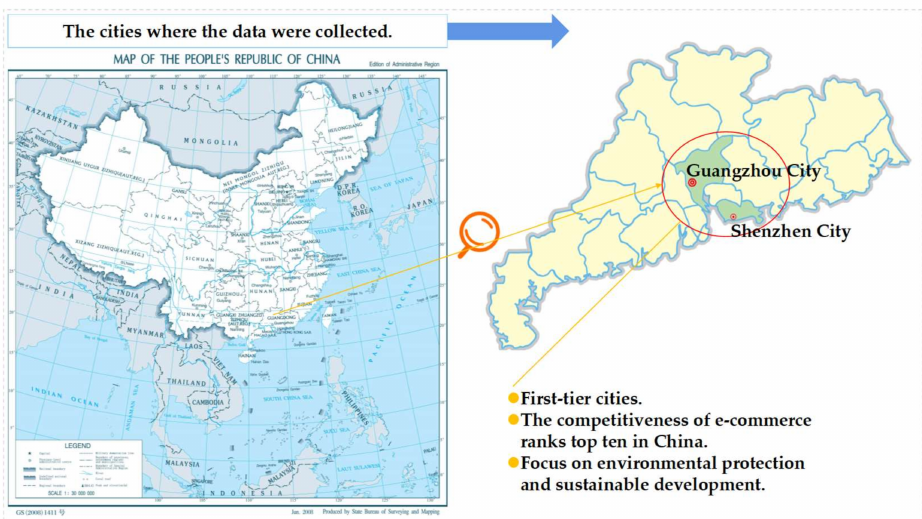
Figure 3. The cities where the data were